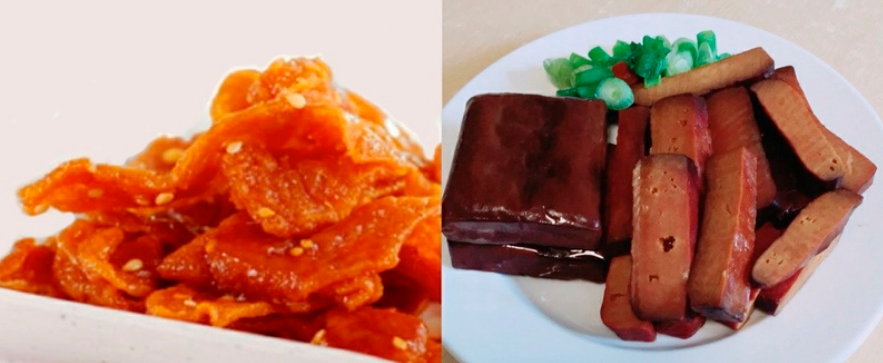
Figure 3. Typical Daxi togan (right) and togan made as a snack (left). Source: Authors.